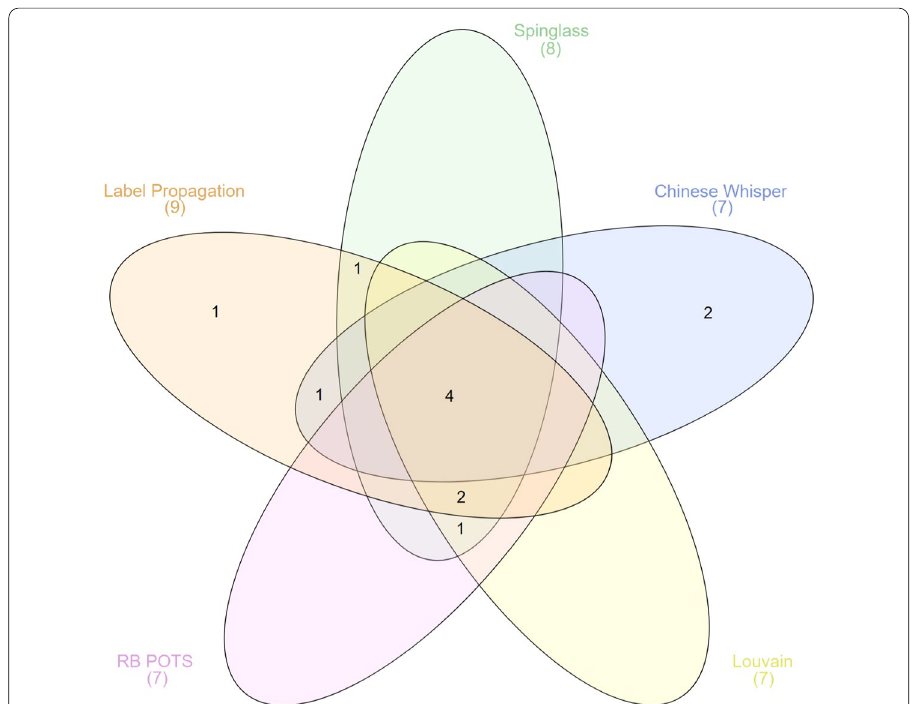
Table 7 Algorithm and significant disease Algorithm Disease Label Propagation and Spinglass and Chinese whisper and Louvain and RB POTS Label Propagation and Spinglass and Louvain and RB